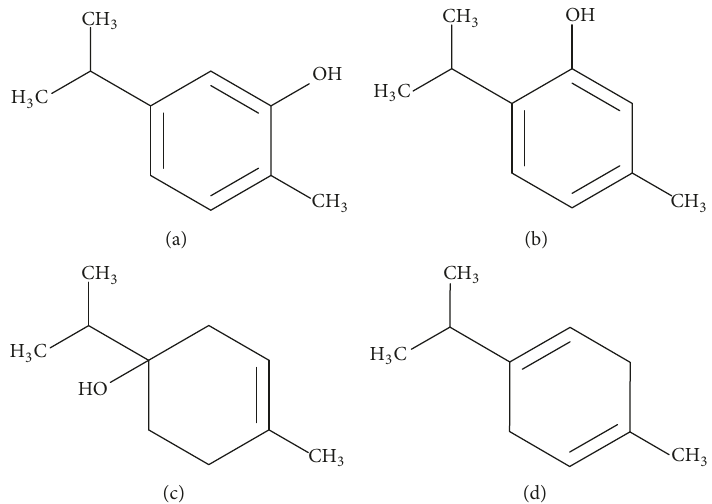
Figure 1: Chemical structures of (a) carvacrol, (b) thymol, (c) terpinen-4-ol, and (d) 𝛾 terpinene, that is, the active constituents of the oregano and marjoram essential oils.